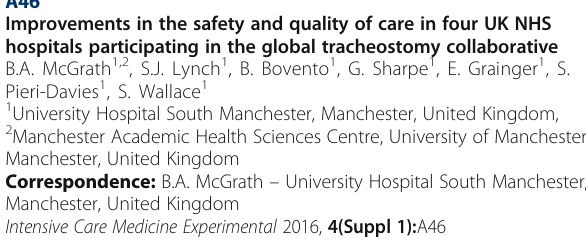
Fig. 22 (abstract A46). Trends in reported patient safety